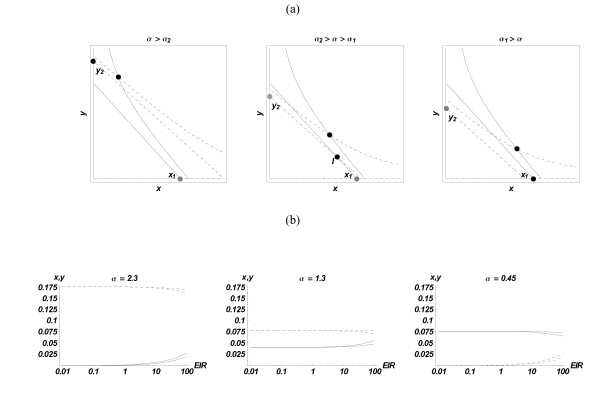
Phase-plane of dynamical system (4). (a) Phase-plane views of 3 regions of system (4) in terms of relative growth rate α : y-domination (equilibrium y2, left); coexistence (equilibrium I, middle) and x-domination (equilibrium x1, right). Stable equilibria are marked in black. In all 3 cases, adding sources (inoculations) produces a stable coexistence equilibrium (intersection of asymptotic hyperbolae). The two solid lines are x-nullclines F(x, y) = 0, the two dashed lines are y-nullclines G(x, y) = 0. (b) Equilibria (4) for stationary sources SX,Y (x(ε) – solid, y(ε) – dashed), with the parameters of Table 1, in 3 different ranges of α, as functions of EIR, 0 <ε < 100. Two sets of curves on each plot correspond to different partitions of EIR among strains: (i) pX = pY = .5 (outer curves), (ii) pX = .9; pY = .1 (inner 'x-biased' curves). The two solid lines are x-strains, and the dashed lines are y-strains.